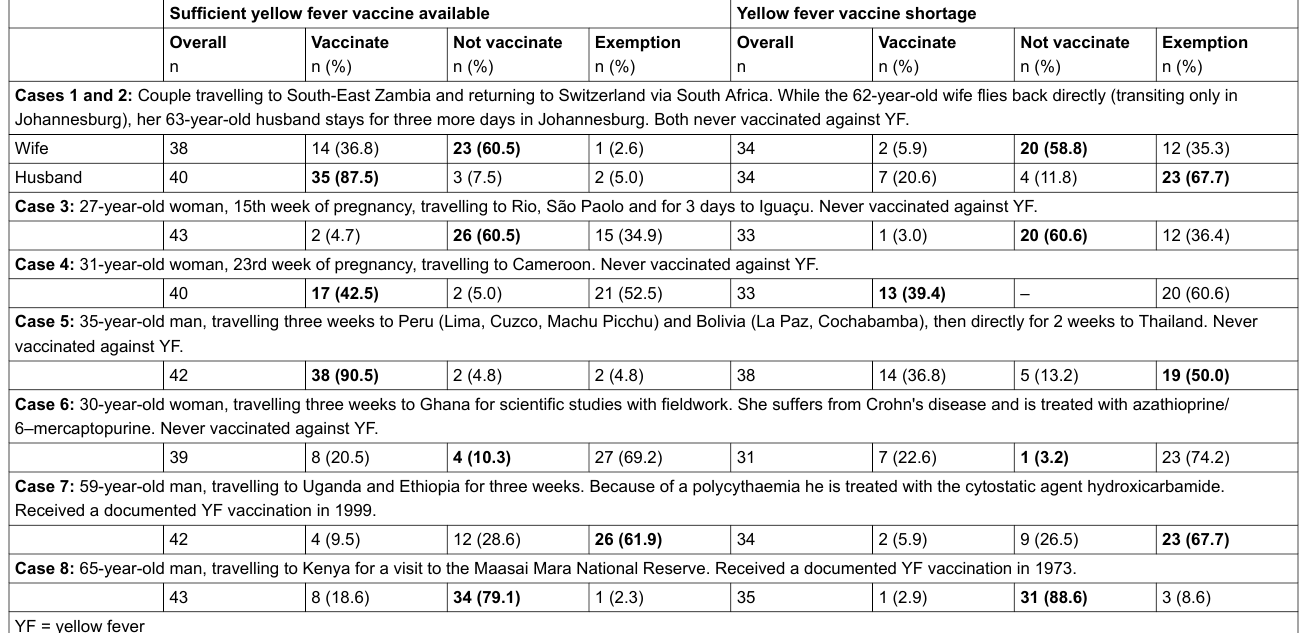
Table 1: Case descriptions and results from the yellow fever vaccination survey among Swiss tropical and travel health experts. Sufficient yellow fever vaccine